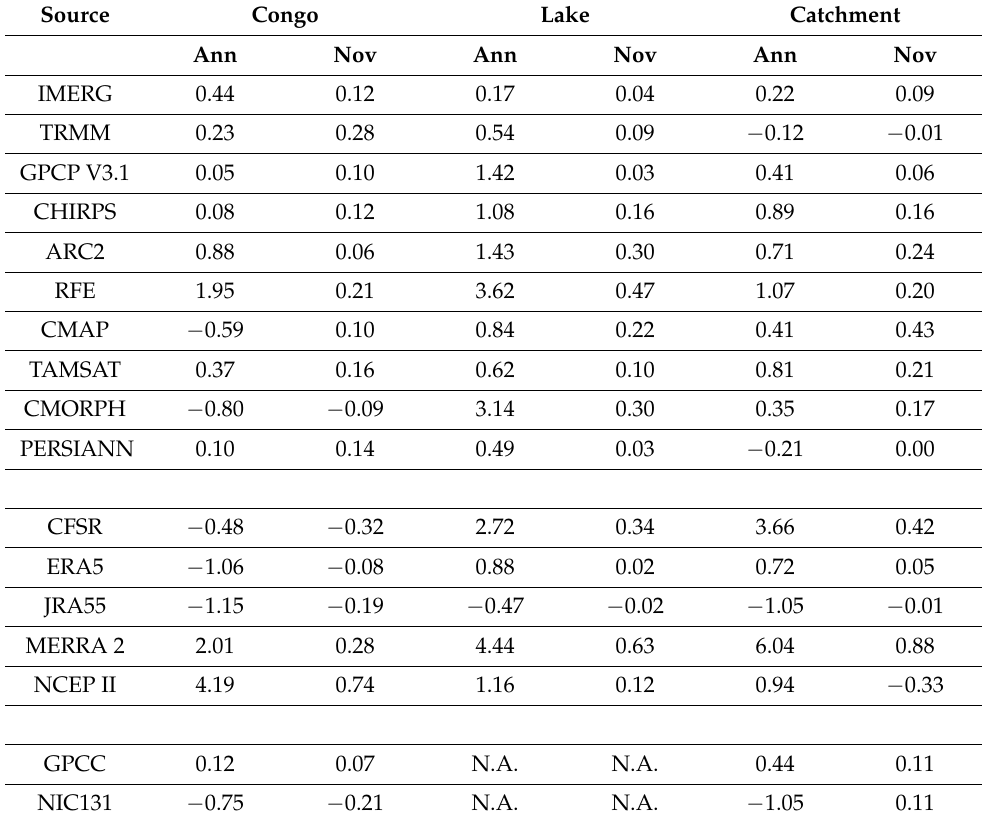
Table 4. Rainfall trends (mm/year/decade) over the period 2001–2019 for annual and November rainfall in the three areas shown in Figure 1: N.A. in the lake column indicates the product has no stations over the lake. Source Congo Lake Catchment Ann Nov Ann Nov Ann